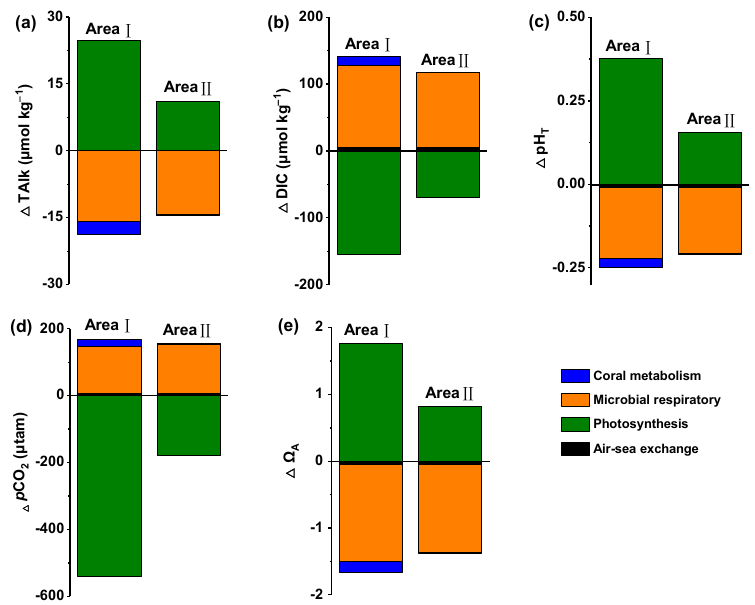
Figure 7. The contribution of photosynthesis, microbial respiration, coral metabolism and air–sea exchange to inorganic carbon dynamics ( a – e ) of the entire study area of Yangmeikeng Sea Area (Area I) and Dalu Bay (Area Ⅱ ) in November.